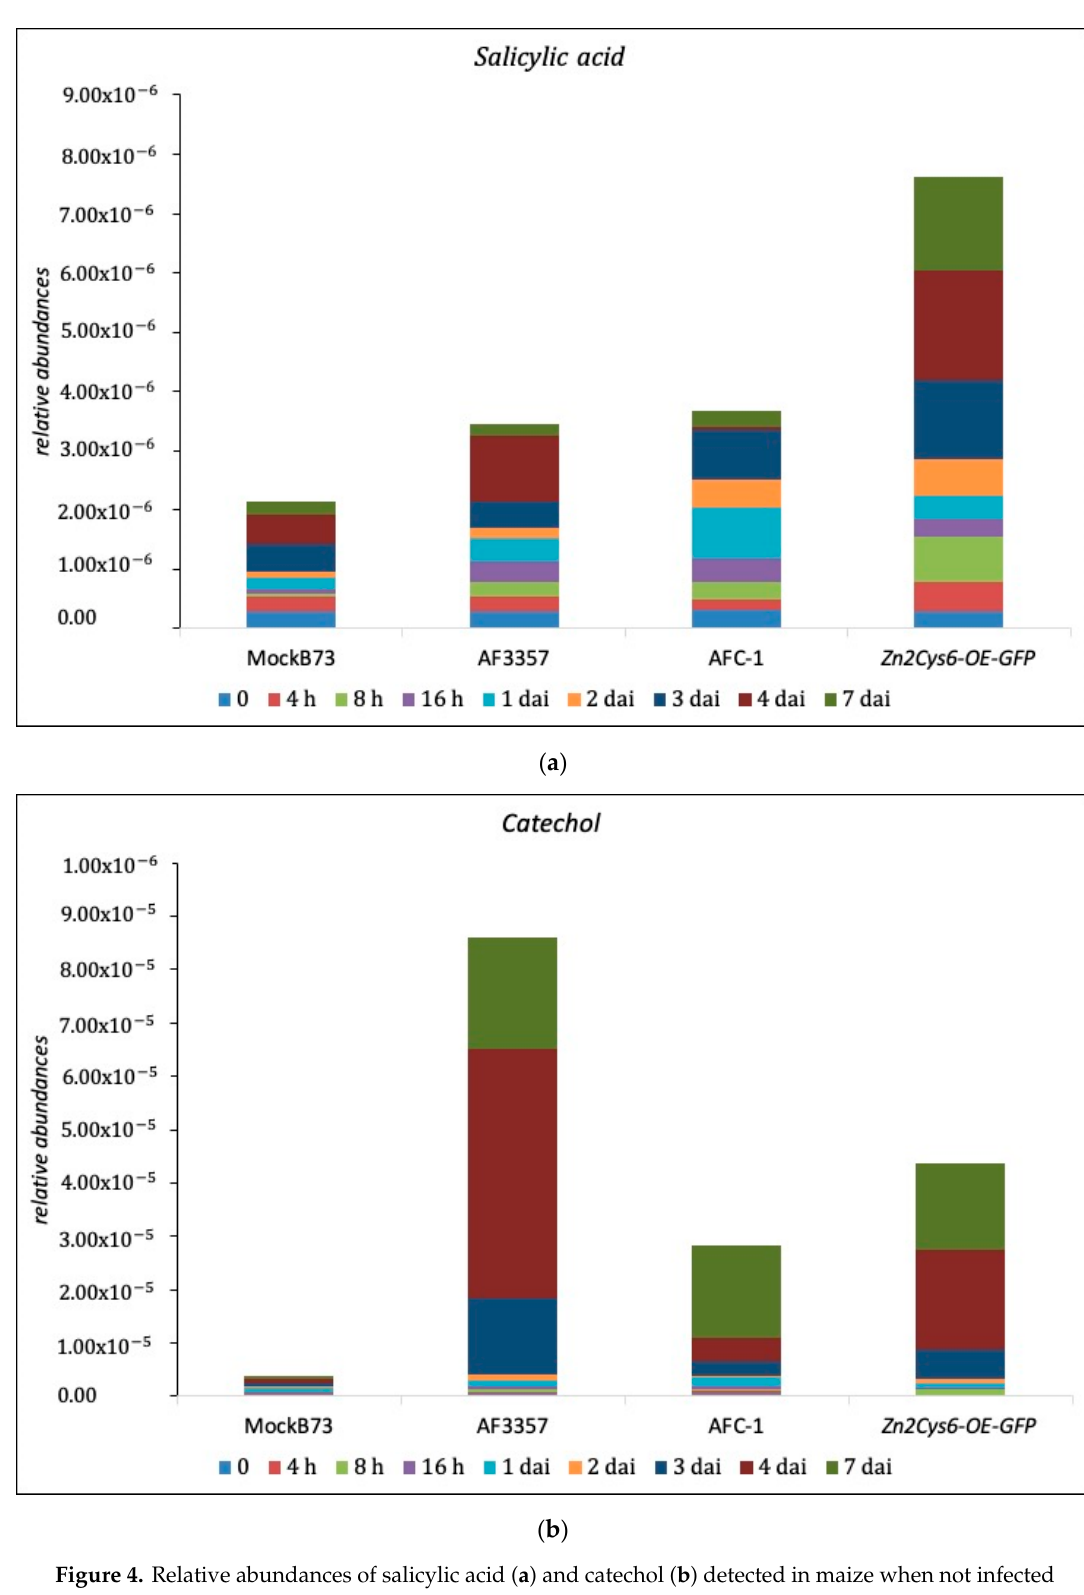
Figure 4. Relative abundances of salicylic acid ( a ) and catechol ( b ) detected in maize when not infected (MockB73) or infected with one of three A. flavus strains. The colours in each bar represent different infection time points.